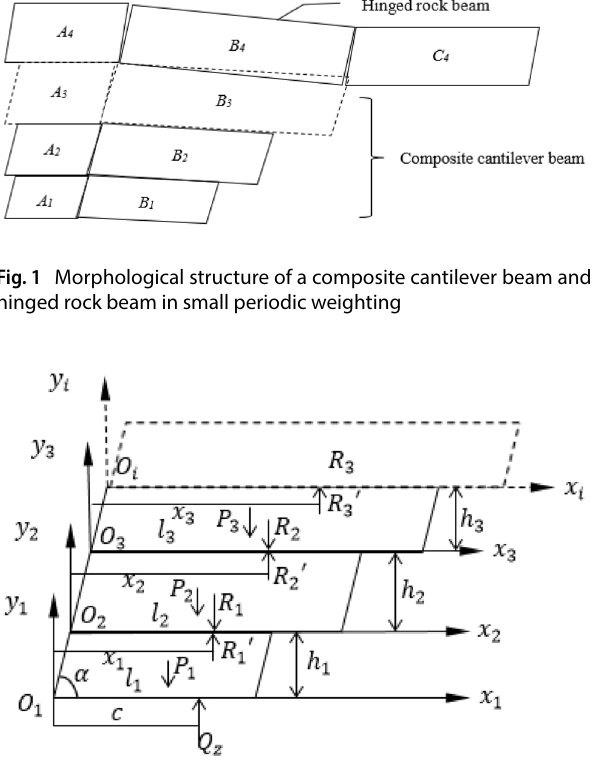
Fig. 2 Mechanical analysis of a composite cantilever beam in small periodic